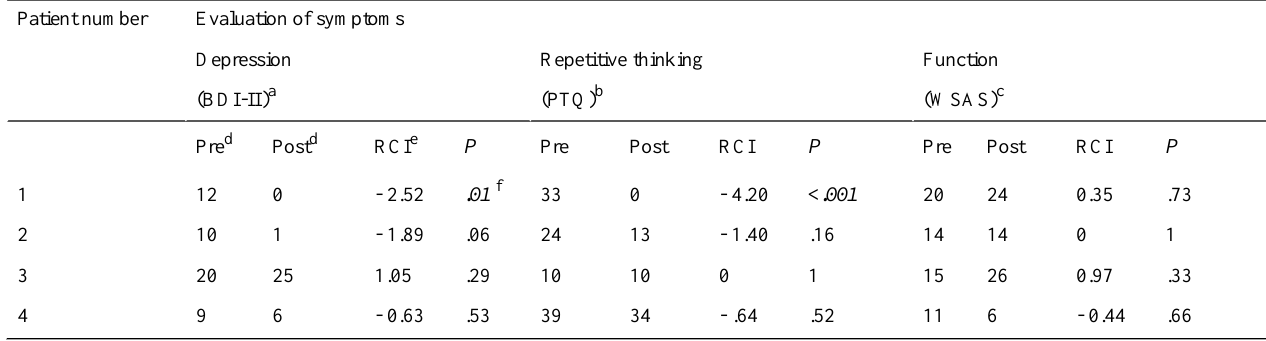
Table 3. Pre-/posttest evaluation on BDI-II, PTQ, and WSAS. Evaluation of symptomsPatient